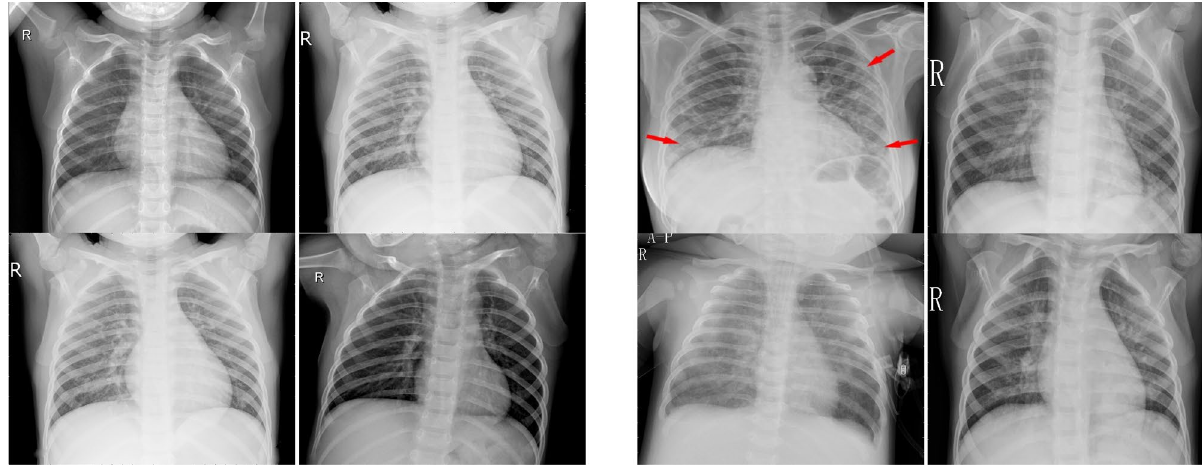
Figure 5. Chest X-ray of normal (CoViD19−ve) and CoViD19+ve.